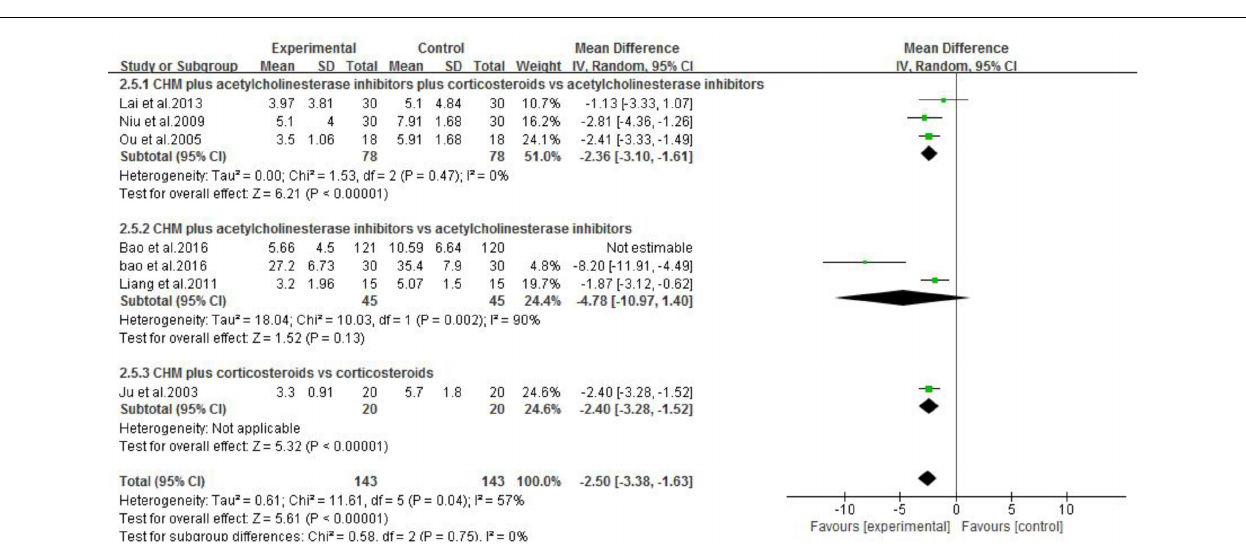
FIGURE 3 | The forest plot: Recovery rate of CHM vs. WCM.